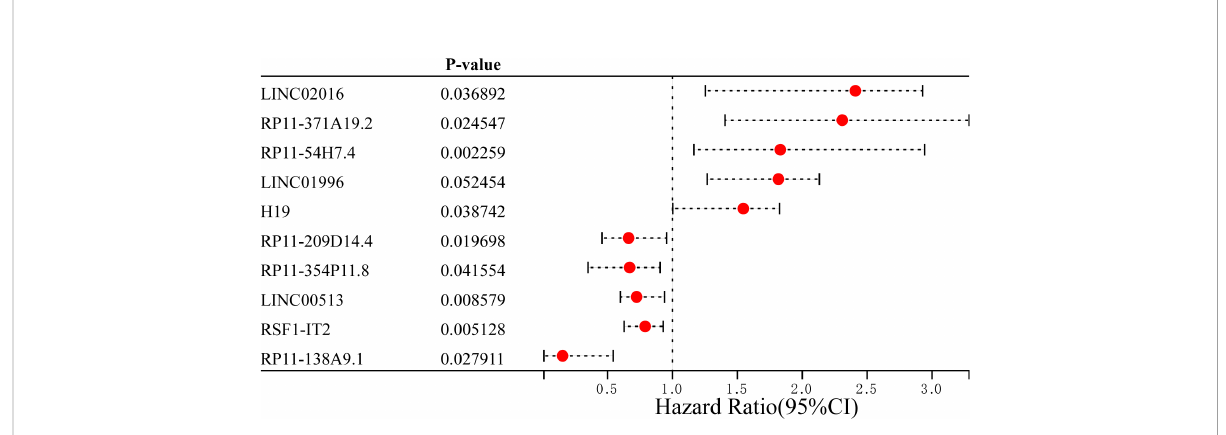
FIGURE 2 Top 5 differentially upregulated and downregulated ferroptosis-related long non-coding RNAs between lung adenocarcinoma and normal samples. HR, hazard